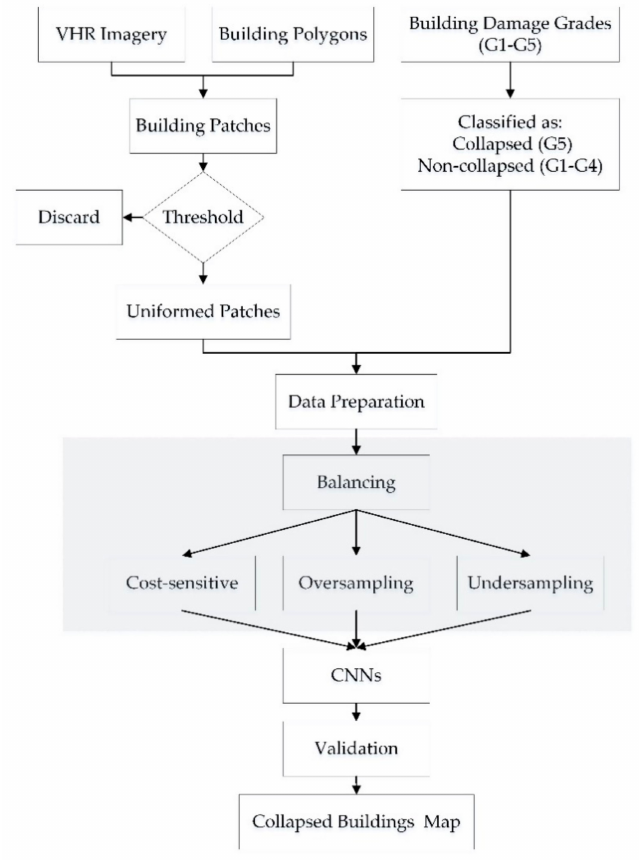
Figure 3. Workflow of mapping collapsed buildings using very high resolution (VHR) imagery and convolutional neural networks